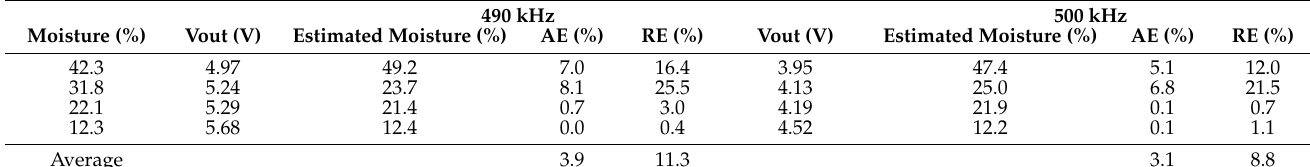
Table 12. Verification NP2, 490 kHz, and 500 kHz one model.